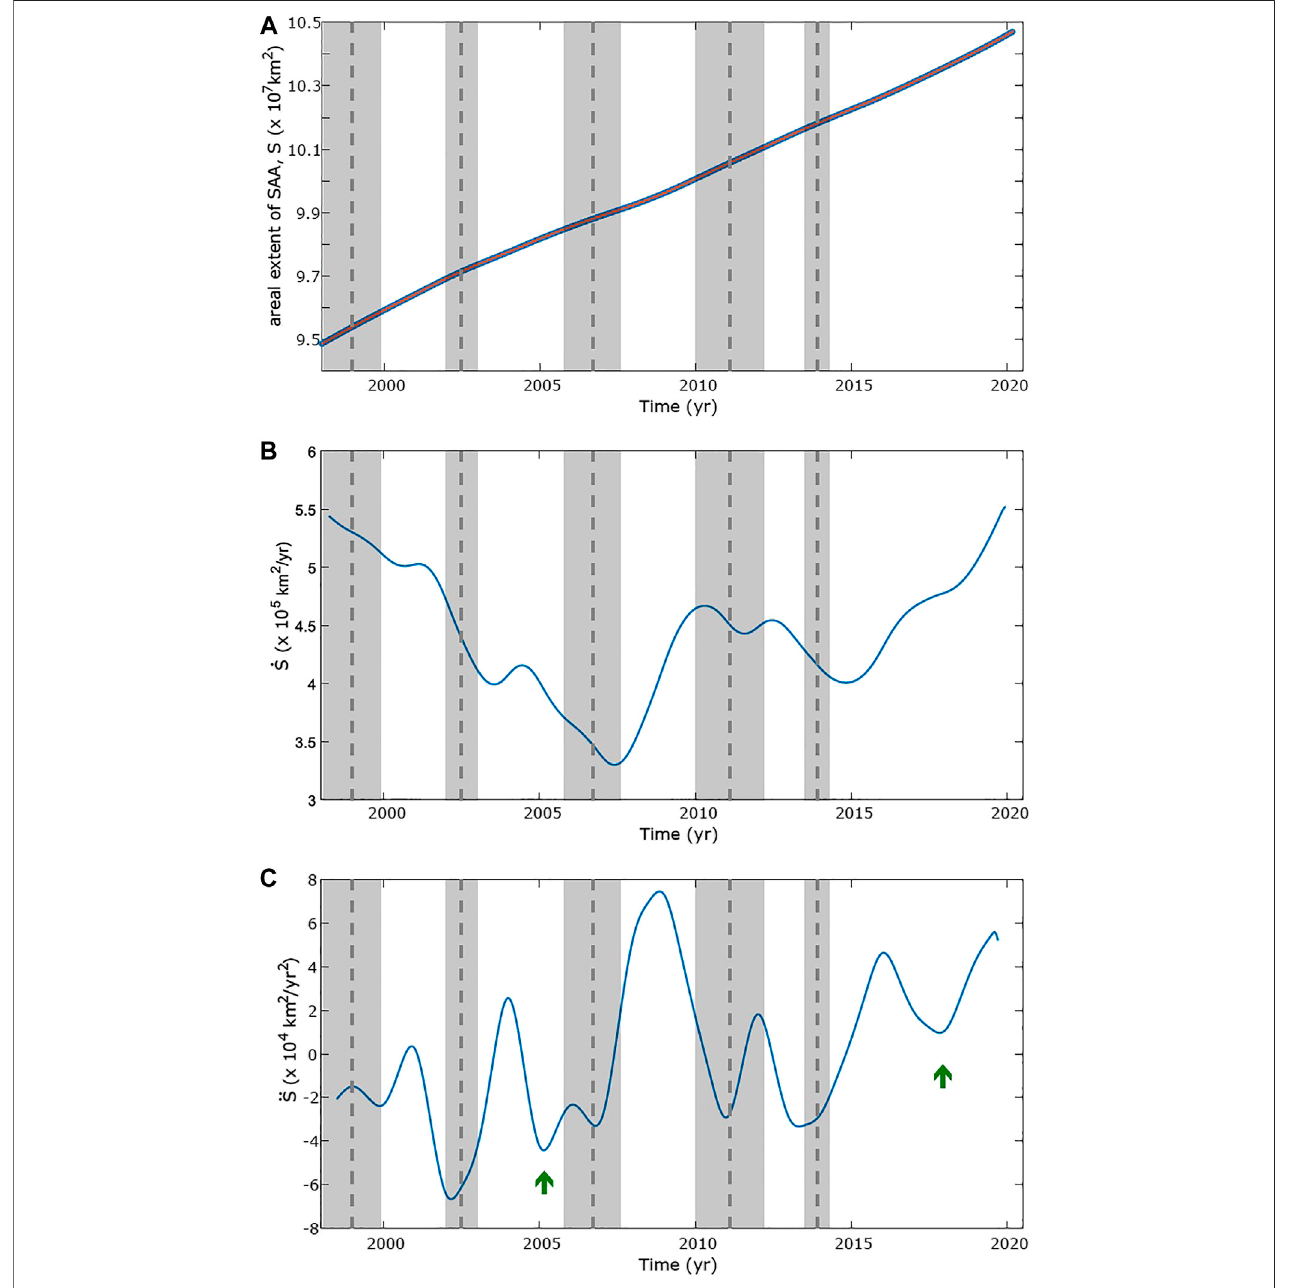
FIGURE2| SouthAtlanticAnomalyevolution. (A) EvolutionS, (B) fi rstderivativeS ̇ ,and (C) secondderivativeS ̈ ofthearealextentoftheSAAforthelast2 decades calculated from CHAOS-7.2 model monthly from January 1998 to March 2020. The fi t of the areal extent of the SAA by using cubic splines is plotted in orange in (A) . In dashed vertical gray lines, the mean occurrence times of the well-de fi ned geomagnetic jerks for the last 2 decades are marked. Shaded bands mark the uncertainty of the occurrence times given by one standard deviation. With green arrows some interestingfeatures are indicated (see Discussion in the main text for more details).